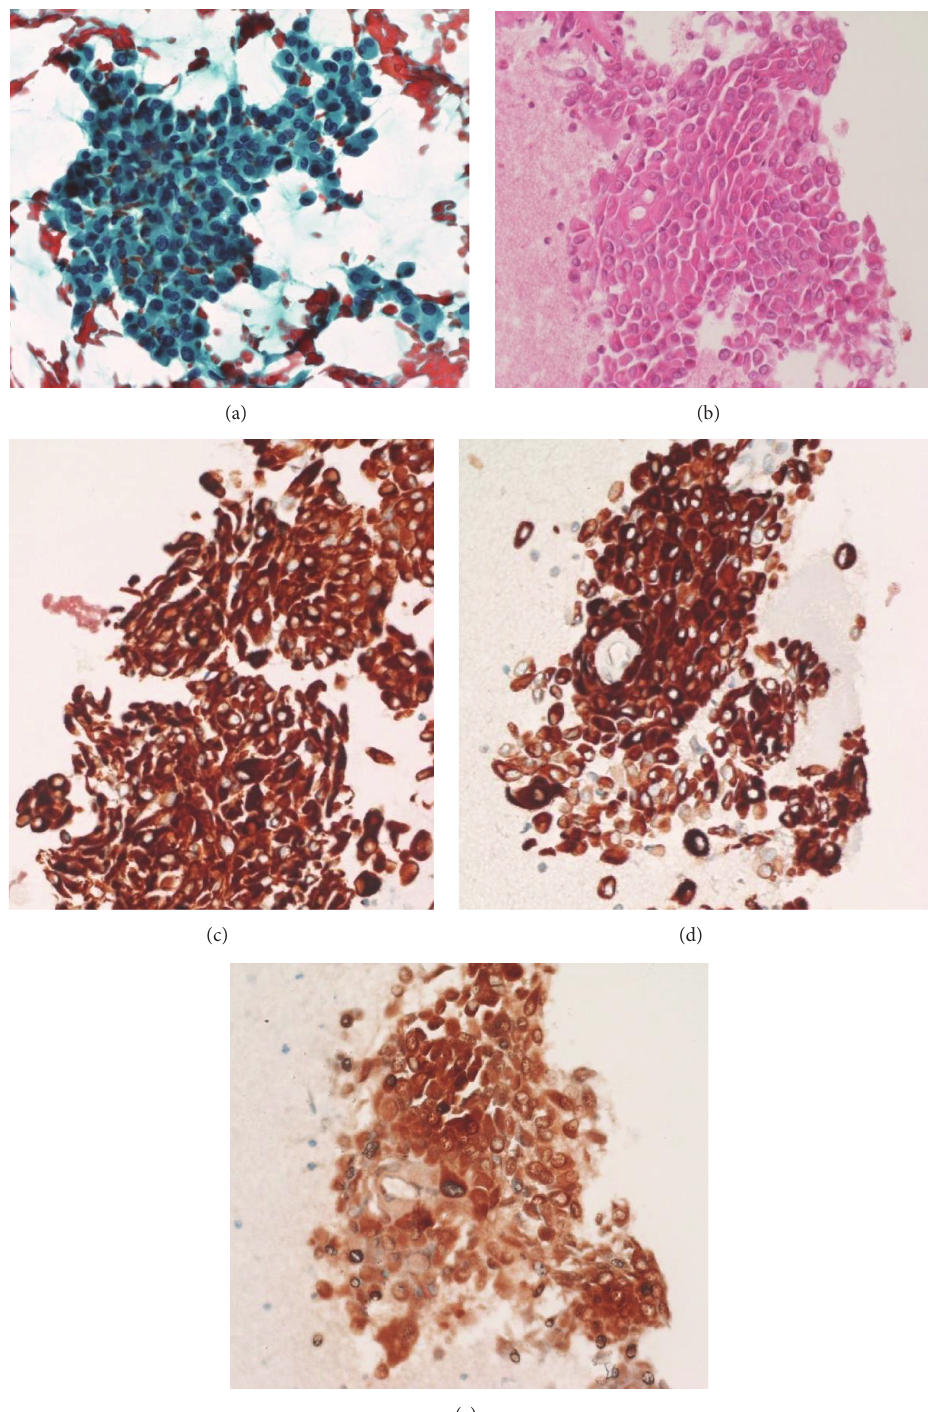
Figure 2: Cytological smears ((a), Papanicolaou staining) and histological sections from cytoinclusion ((b), H&E staining) showed nests of epithelioid cells, strongly positive for anti-pan-cytokeratin (c), anti-HMWCK, and S-100 (e) antibodies ((a–e): magnification